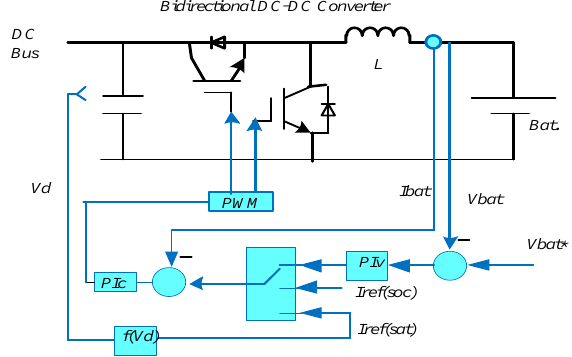
Figure 3. Constant current (CC) and Constant voltage (CV) control mechanisms for charging and discharging of an EV battery.